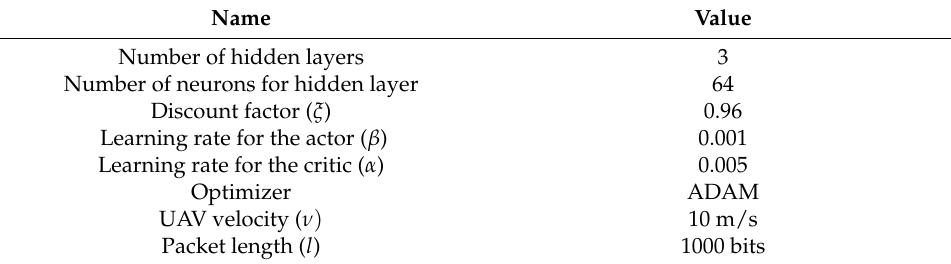
Table 3. Simulation